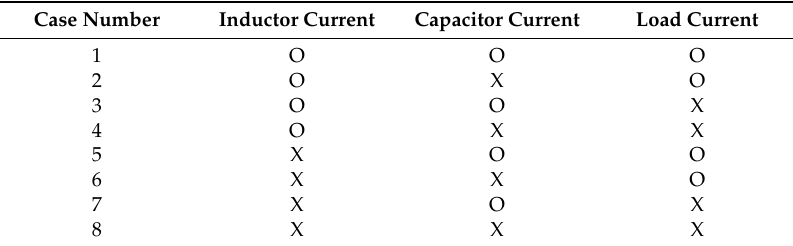
Table 1. Cases of the current sensor